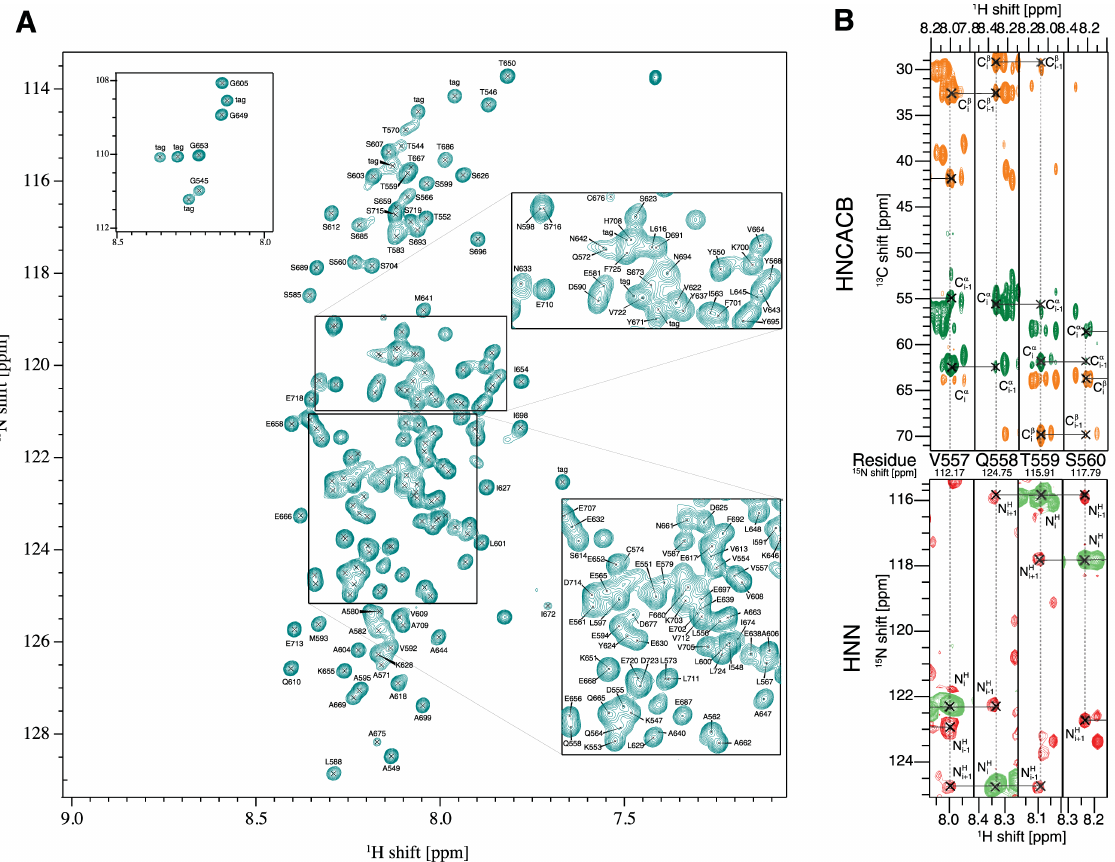
Fig 2. 2D [ 15 N, 1 H]-HSQCand somestripsof 3D tripleresonanceexperiments used for the sequentialassignment of Nogo-A- Δ 20. A : Assigned [ 15 N, 1 H]-HSQCof Nogo-A- Δ 20 following the numbering scheme of rat Nogo-A.The narrow chemical shift dispersion is a commonfeature of intrinsically disorderedpolypeptides (IDPs). B : At the top, stripsof the 3D HNCACB spectrumare shown with green and orange contoursindicating positive and negative cross peaks, respectively. At the bottom, stripsof the 3D HNN spectrumare shown with red and green contoursindicatingpositive and negative cross peaks, respectively. In the HNCACB, cross peaks belongingto C α , C α i-1 , C β , and C β i-1 are indicated, while in the HNN spectrum,the N i , N i-1 , and N i+1 are labelled. The HNCACB spectrumwas recordedat a 600 MHz and the HNN spectrumwas recordedat a 700 MHz NMR spectrometer at 6°C and pH 7.4.